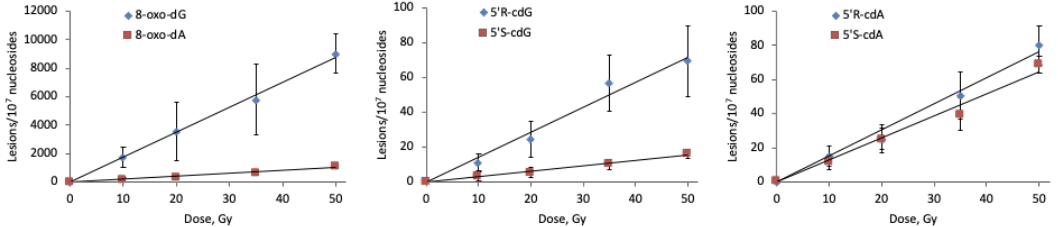
Figure 9. Radiation induced formation of 8-oxo-dG, 8-oxo-dA, 5 ′ R -cdG, 5 ′ S -cdG, 5 ′ R -cdA, and 5 ′ S - cdA in ct-DNA Procedure (i). Each sample was exposed to 0, 10, 20, 35, and 50 Gy dose in N 2 O- saturated aqueous solutions; the values represent the mean ± SD of n = 3 independent experiments.